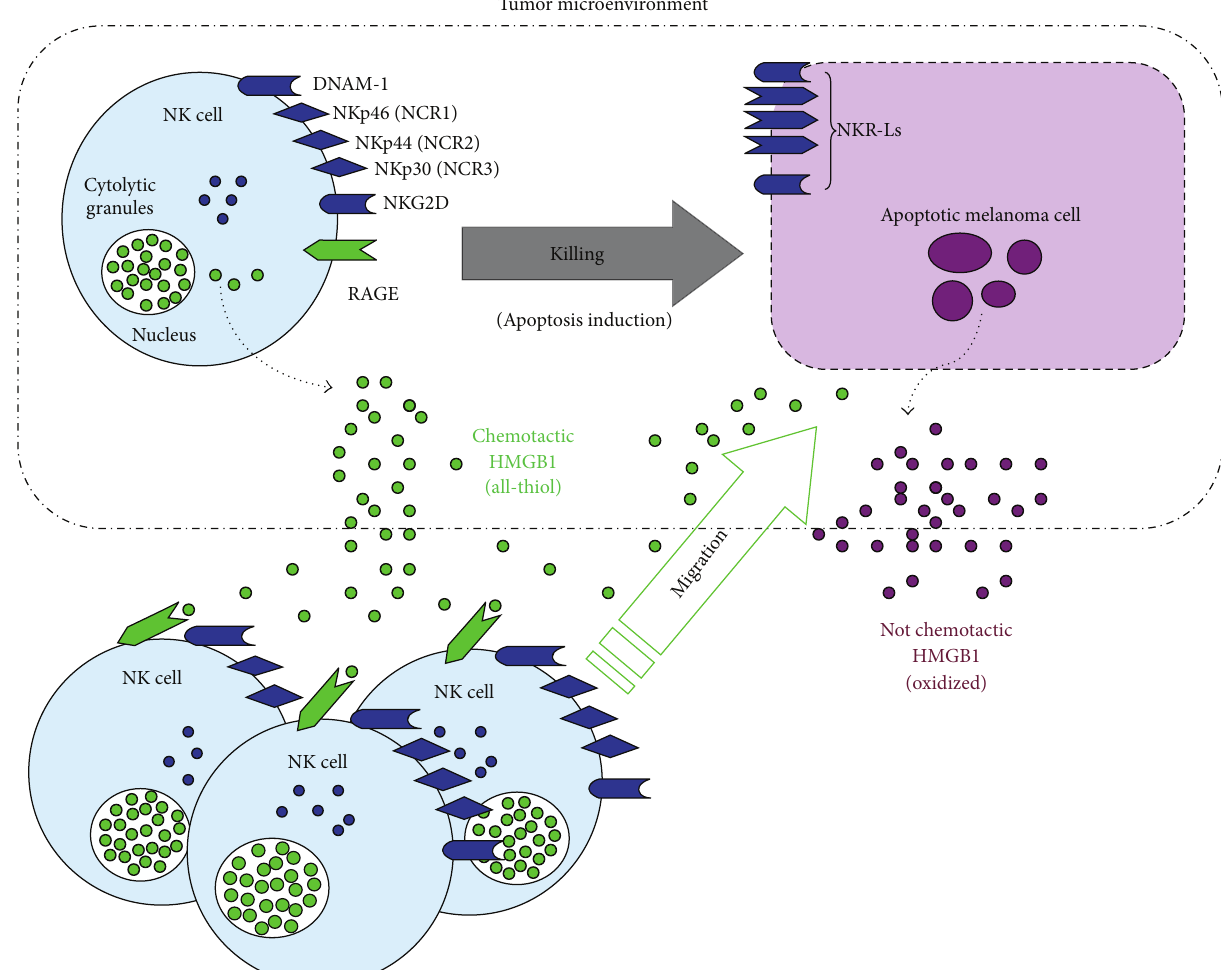
Figure 1: New mechanism proposed for NK cell recruitment at melanoma tumor site. NK cells recognize melanoma cells through the interaction of NK activating receptors with their ligands (NKR-Ls) expressed on tumor cell (both depicted in dark blue). The resulting NK cell activation leads to the killing of melanoma cells (via perforin/granzyme B and induction of apoptosis) and to the active release of a chemotactic form of HMGB1 (green circles). Killed (apoptotic) cells passively release HMGB1 as oxidized molecule. However, this HMGB1 form has no chemotactic properties (purple circles). NK-derived reduced (i.e., all-thiol) HMGB1 can act as chemoattractant for activated NK cells through the engagement of RAGE (depicted in green), thus promoting their recruitment in the tumor